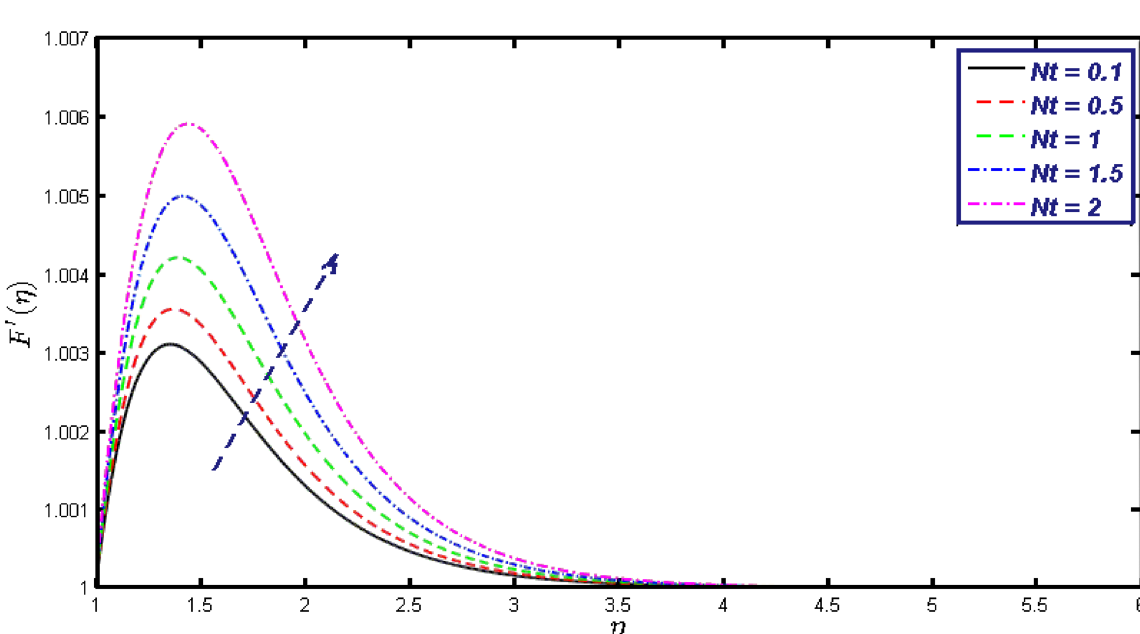
Figure 6. Velocity field for different values of Nt